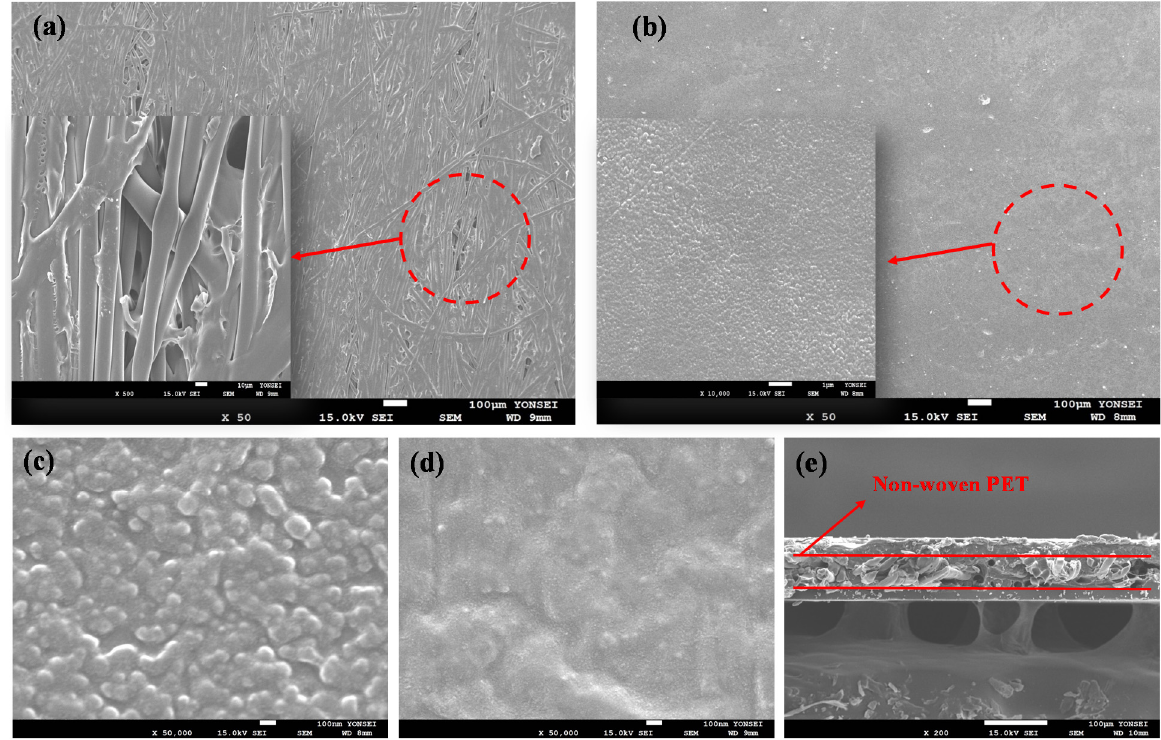
Figure 3. SEM surface images of: ( a ) non-woven PET; ( b ) GDV45 base membrane; ( c ) enlarged surface of GDV45 base membrane; and ( d ) GDV45-TMA membrane; and SEM cross section image of: ( e ) GDV45-TMA.